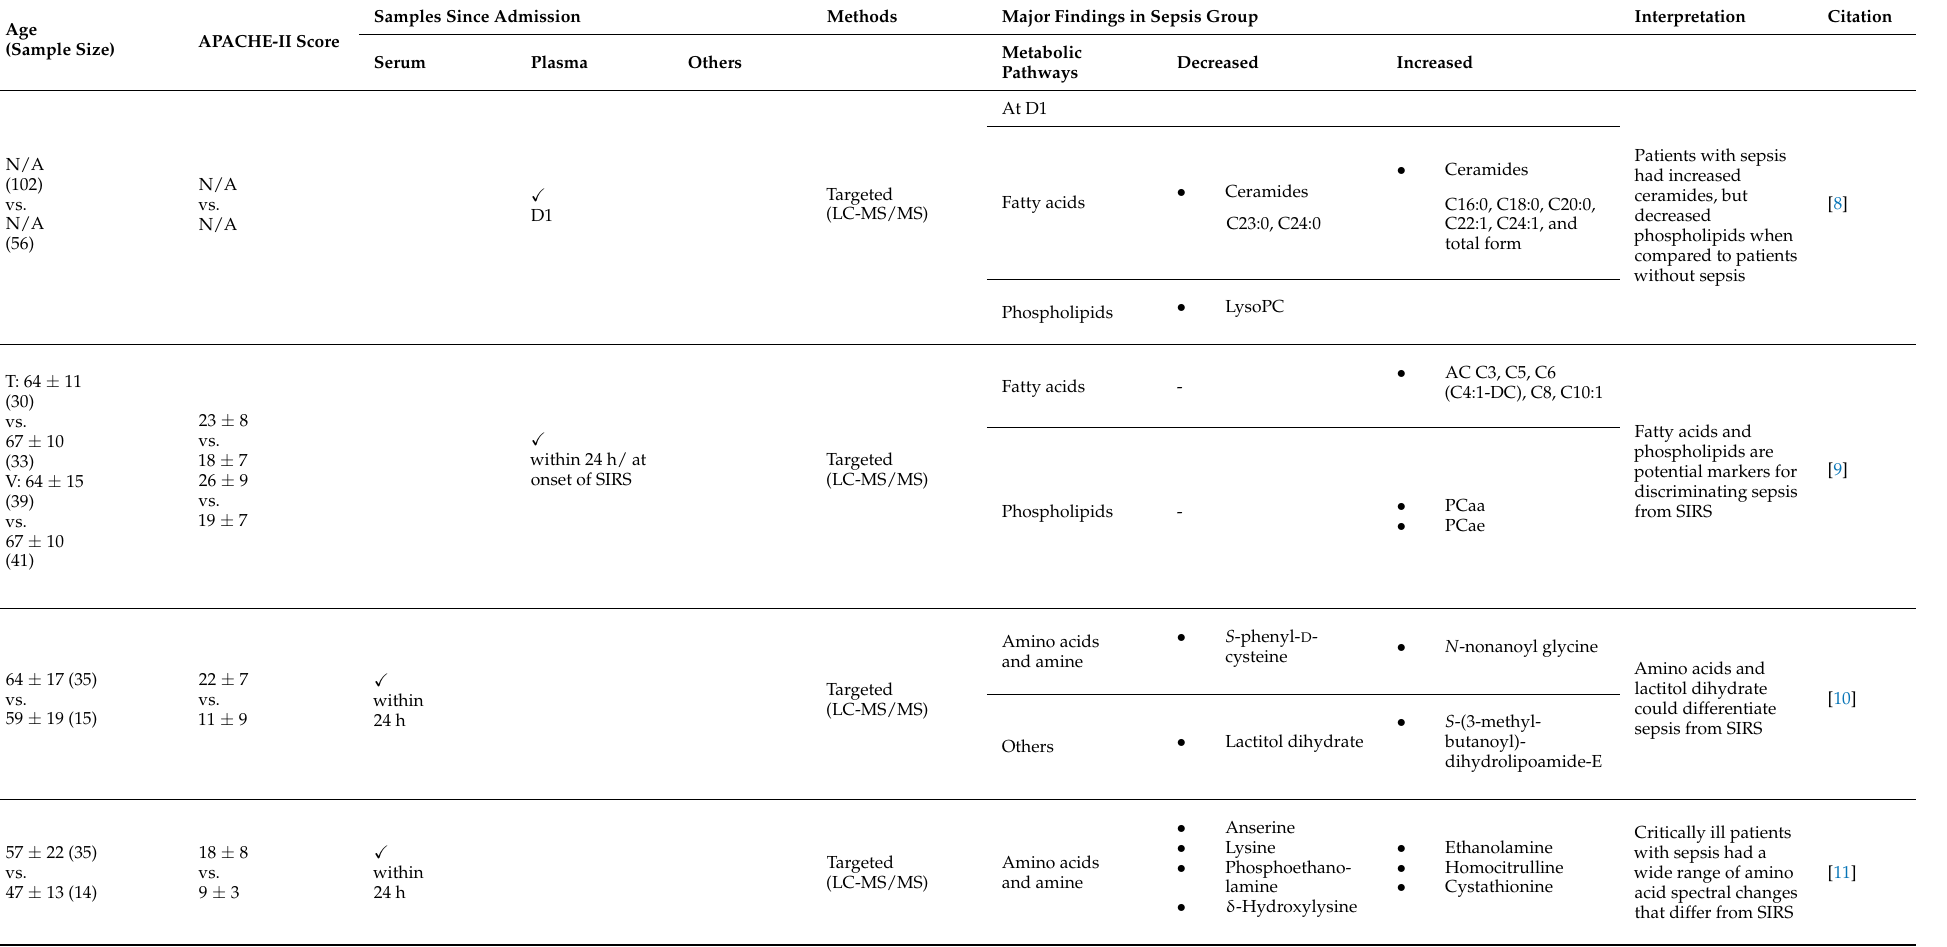
Table 1. Metabolomics-assisted diagnosis of sepsis in critically ill